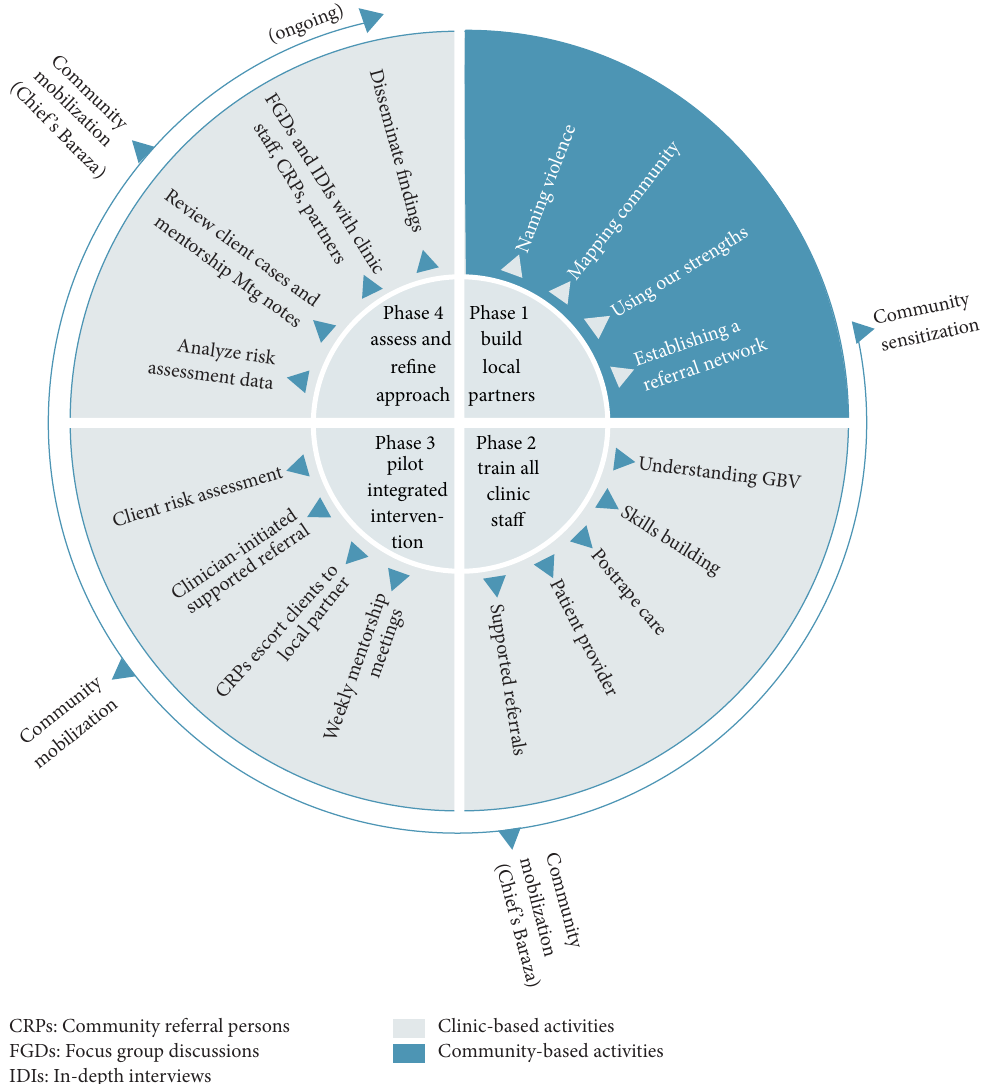
Figure 1: GBV program